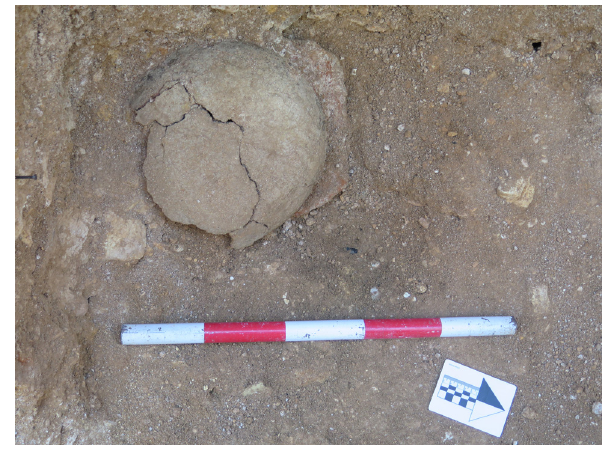
Figure 9: Detail of the infant burial 3 within the cooking pots ( Sp. Finds 4, 6 and 7 ) .